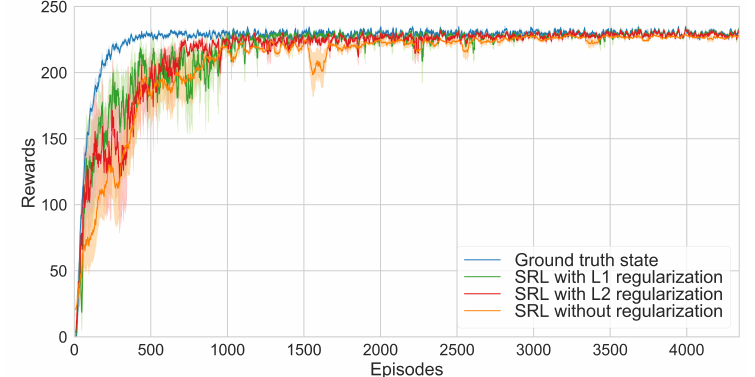
(a) RL performance based on DQN algorithm. Figure 10. Influence of regularization methods on RL performance in mobile robot one-random-target task (mean and standard error for five runs with PPO algorithm). The coefficients of (cid:96) 1 regularization and (cid:96) 2 regularization are set as 10 − 6 and 10 − 3 respectively.